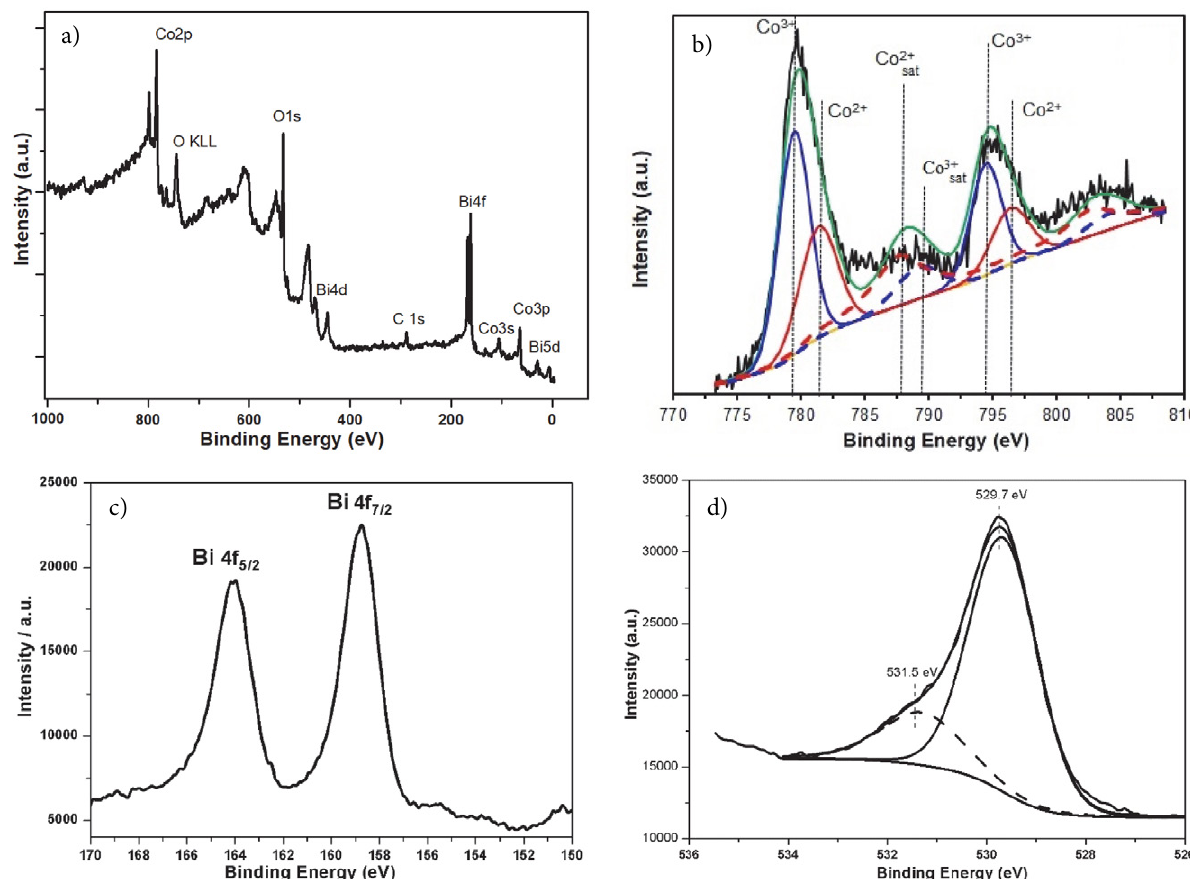
Fig. 4. XPS spectra of 50% Bi 2 O 3 -Co 3 O 4 sample: (a) wide survey, (b) Co 2p, (c) Bi 4f and (d) O1s